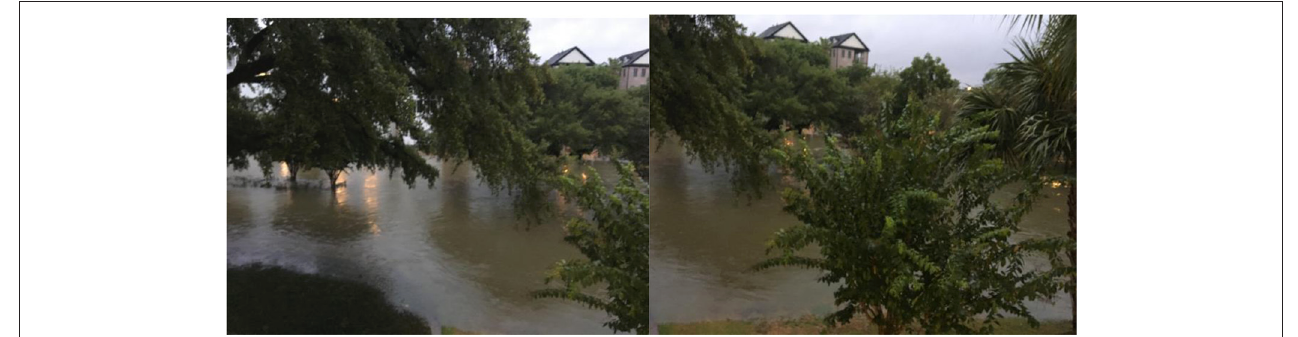
FIGURE 1 | Roads completely submerged by floodwaters near the Texas Medical Center (Crystal